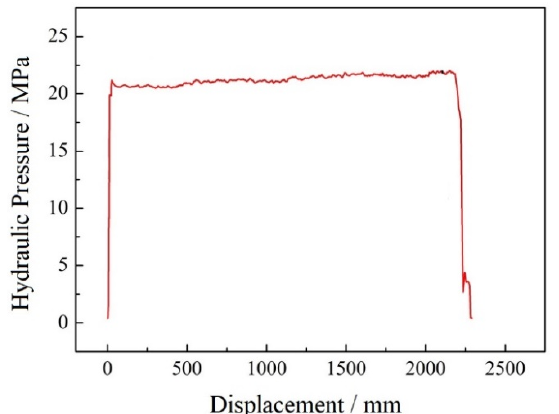
Figure 1. The curve for hydraulic pressure vs. displacement during the expansion of the AISI 304 SS tube.